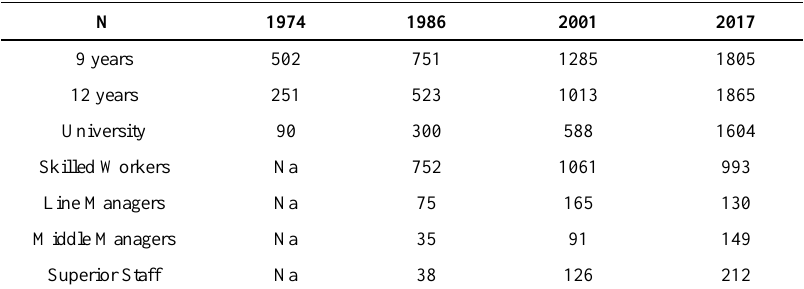
Table 4. Stocks and outcomes of KM in Portugal (thousands) [42].